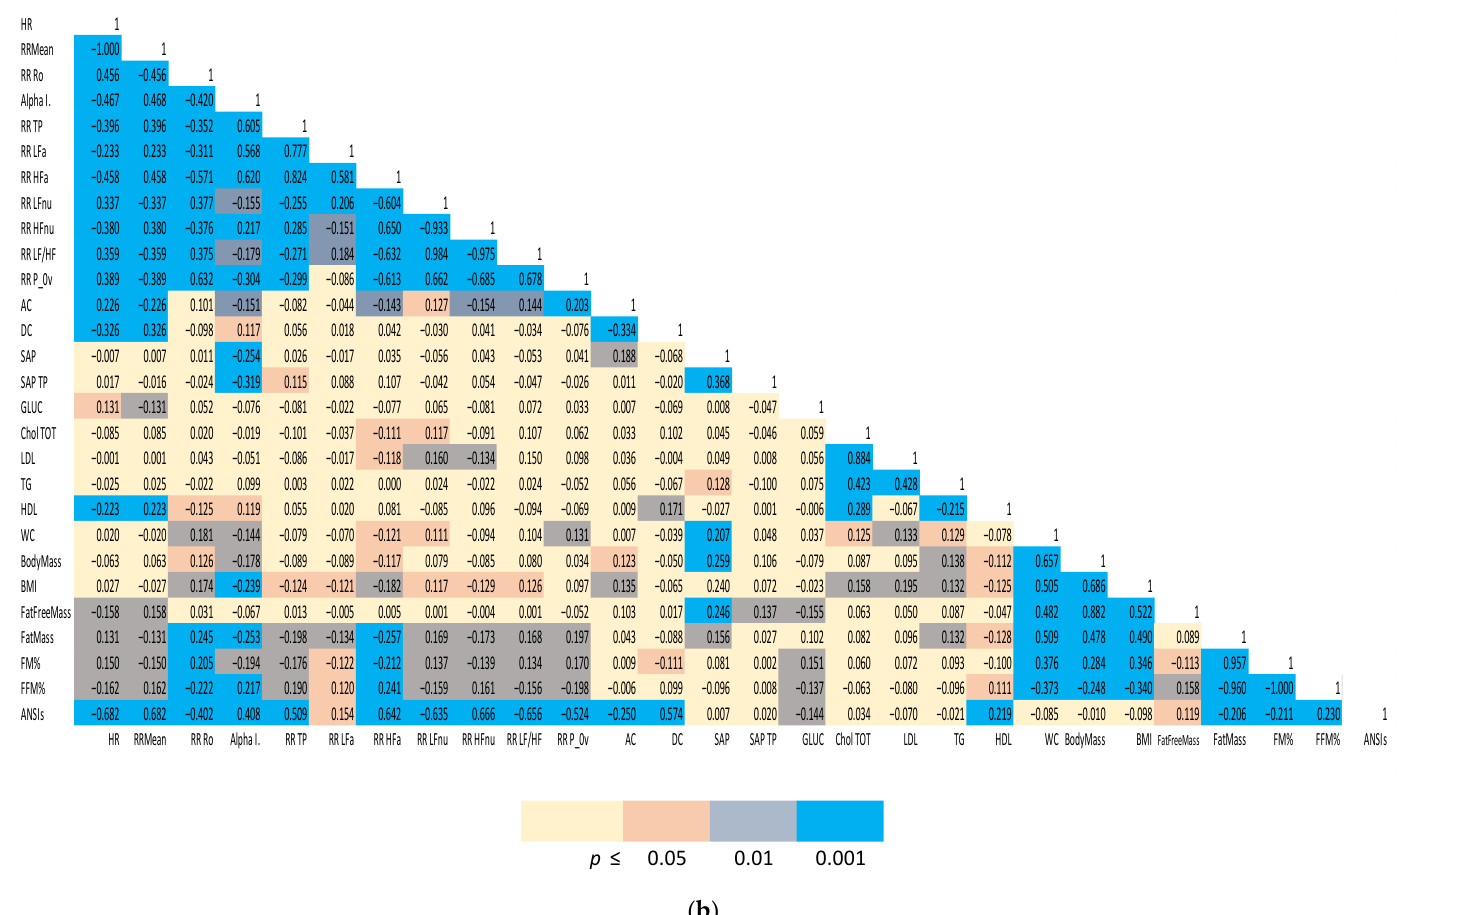
Figure 1. ( a ). Spearman correlation matrix of autonomic, biochemical and body composition in females. ( b ) Spearman correlation matrix of autonomic, biochemical and body composition in males. Color-coded Spearman correlation matrix of selected autonomic and metabolic indices in Olympic athletes, separately computed for females (top panel) and males (bottom panel). Notice that both correlation (r in each cell) and significance level (color-coded cells) are indicated.